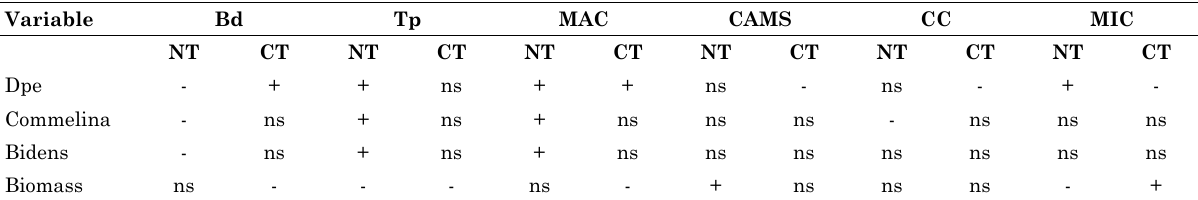
Table 2. Spatial correlations established for weed properties and soil physical properties in no-tillage (NT) and conventional tillage (CT) systems